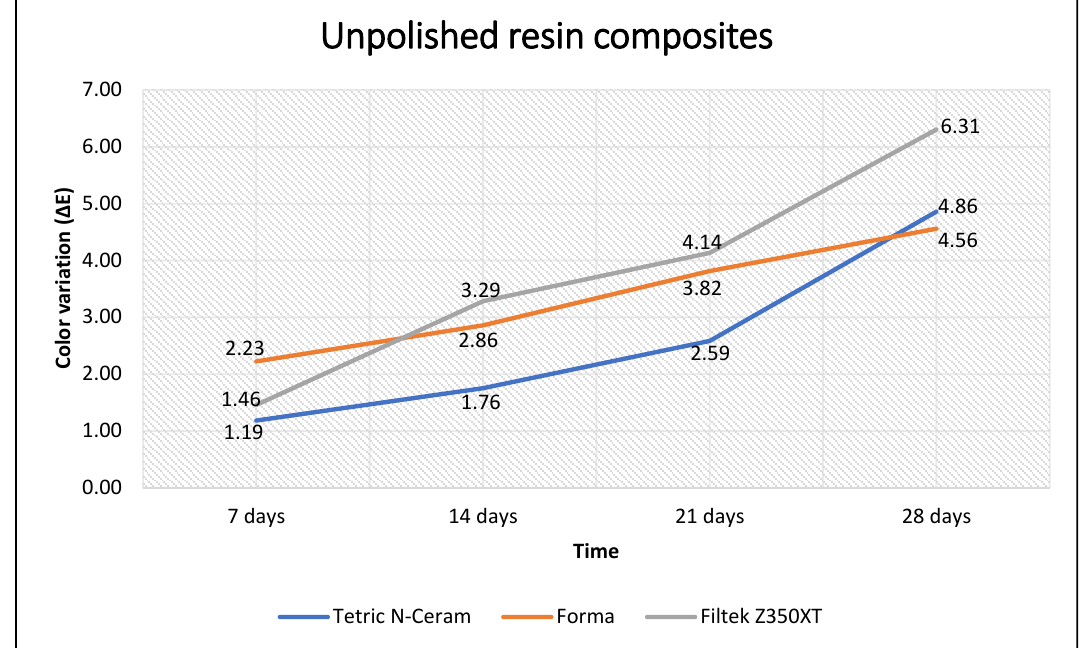
Figure 3. Color variation (ΔE) of unpolished resin composites according to immersion time.